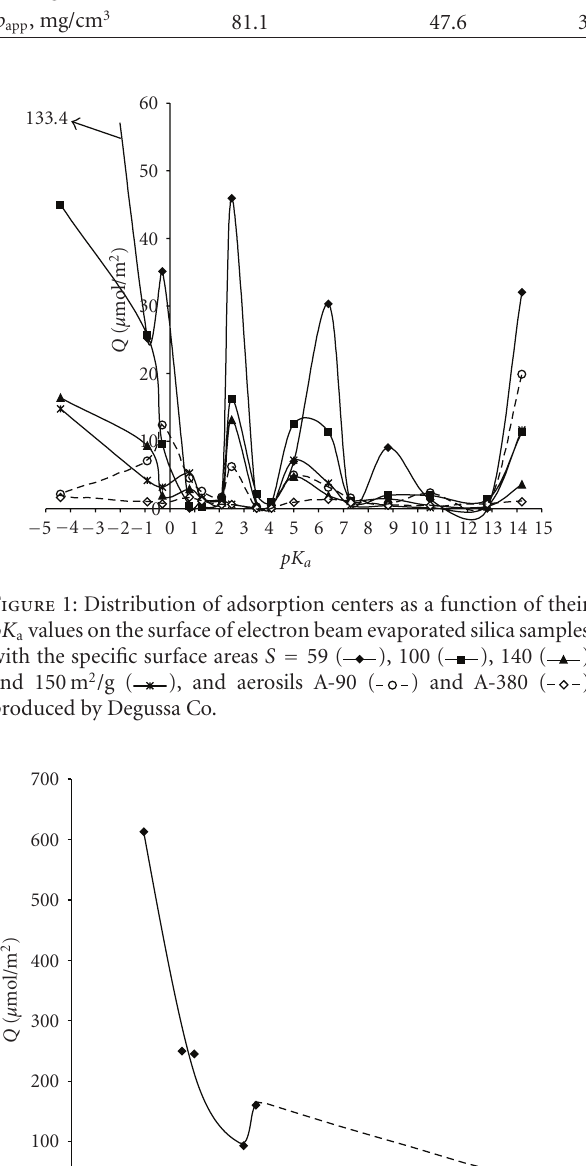
adsorption sites. The overall “porosity” of the synthesized materials reaches the maximum at S = 140 m 2